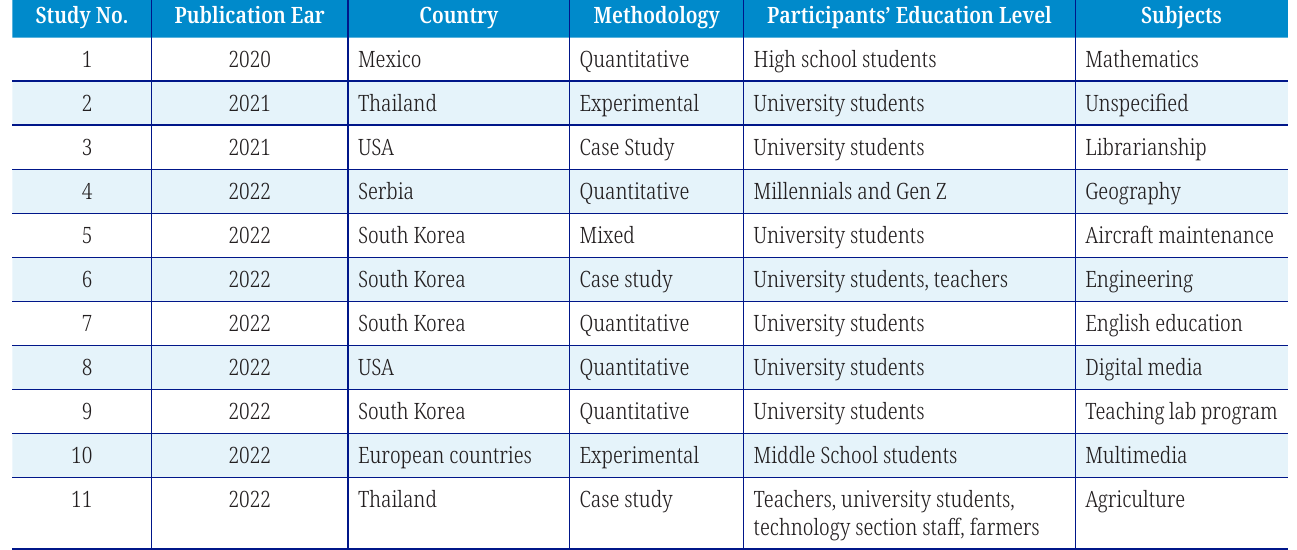
Table 2. Descriptive features of empirical